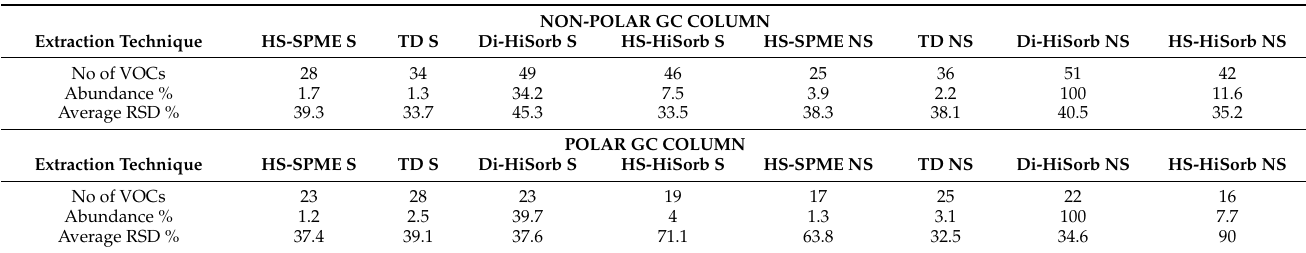
Table 4. Numbers, abundance, and reproducibility of volatile organic compounds in whole milk powder samples extracted by each technique with and without salting out and for polar and non-polar GC